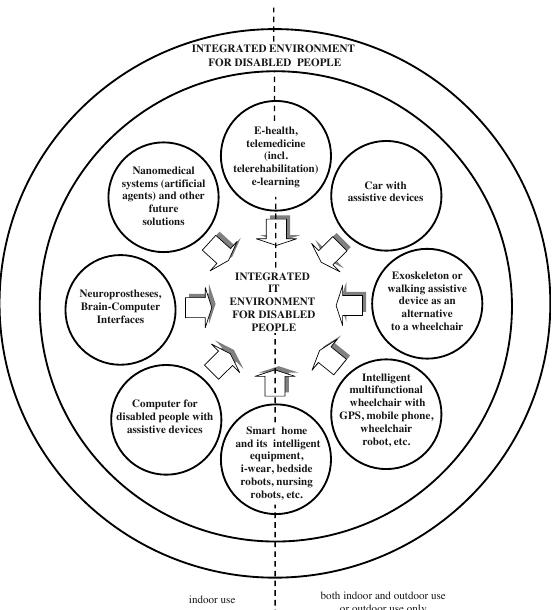
Figure 1. The concept of an integrated IT environment for disabled people